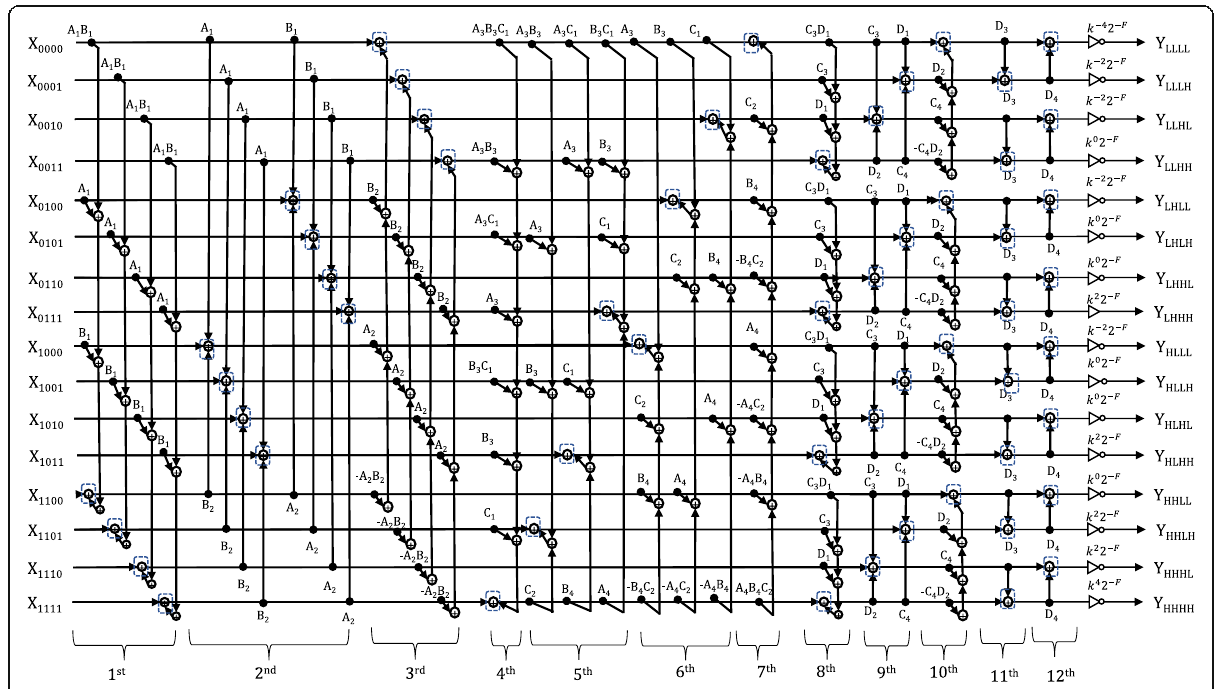
Fig. 6 Non-separable 2D combined with 3D structure for 9/7-type of transform (proposed